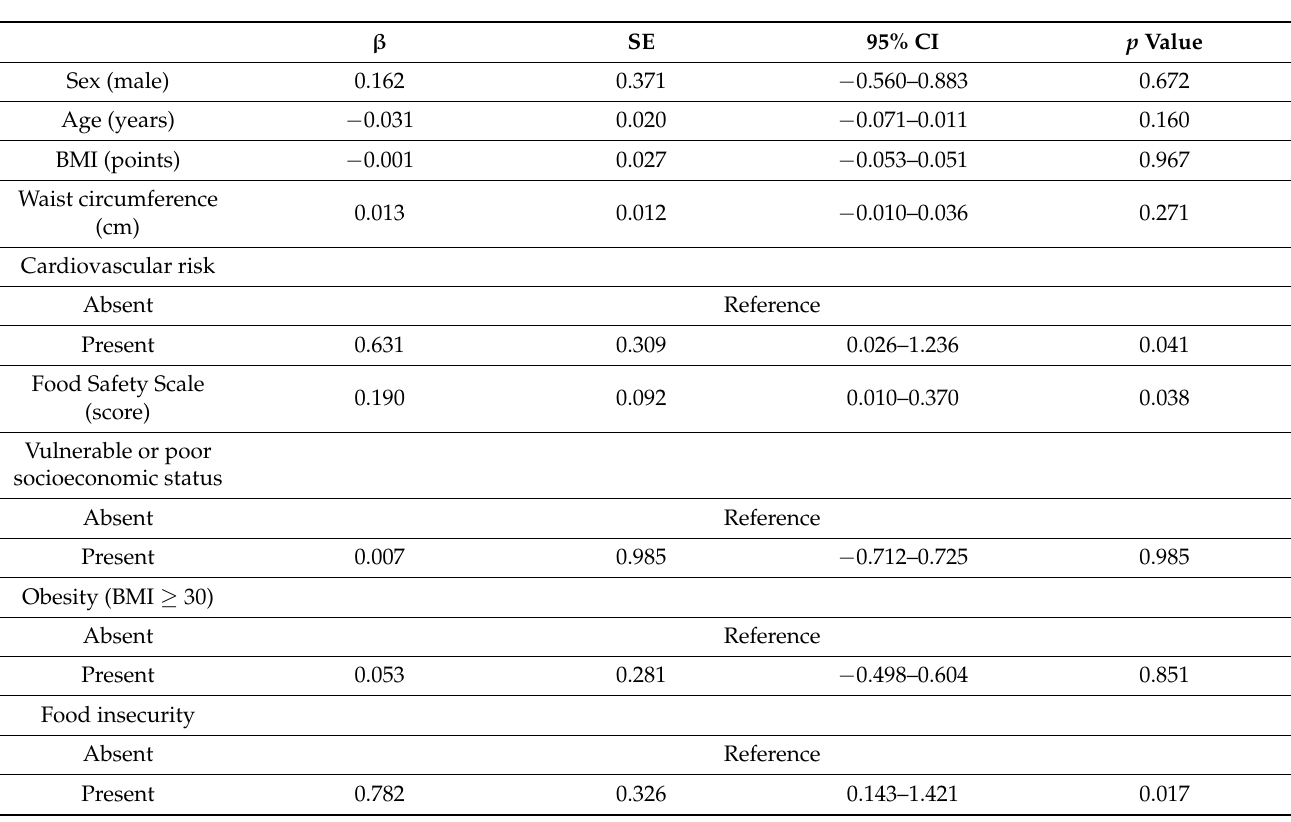
Table 5. Results of the ordinal logistic regression analyses to determine the association between demographic and lifestyle variables with quality of